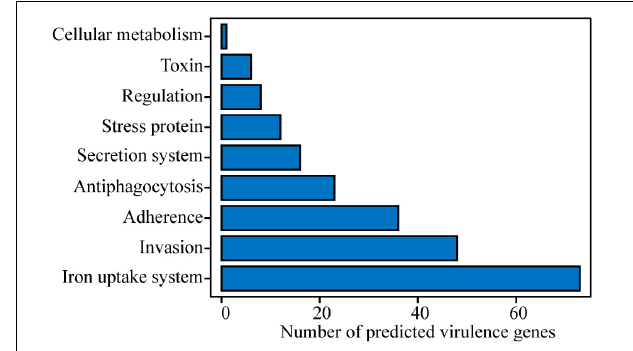
FIGURE 3 | Potential virulence factors in E. persicina strain Cp2 genome predicted by VFDB